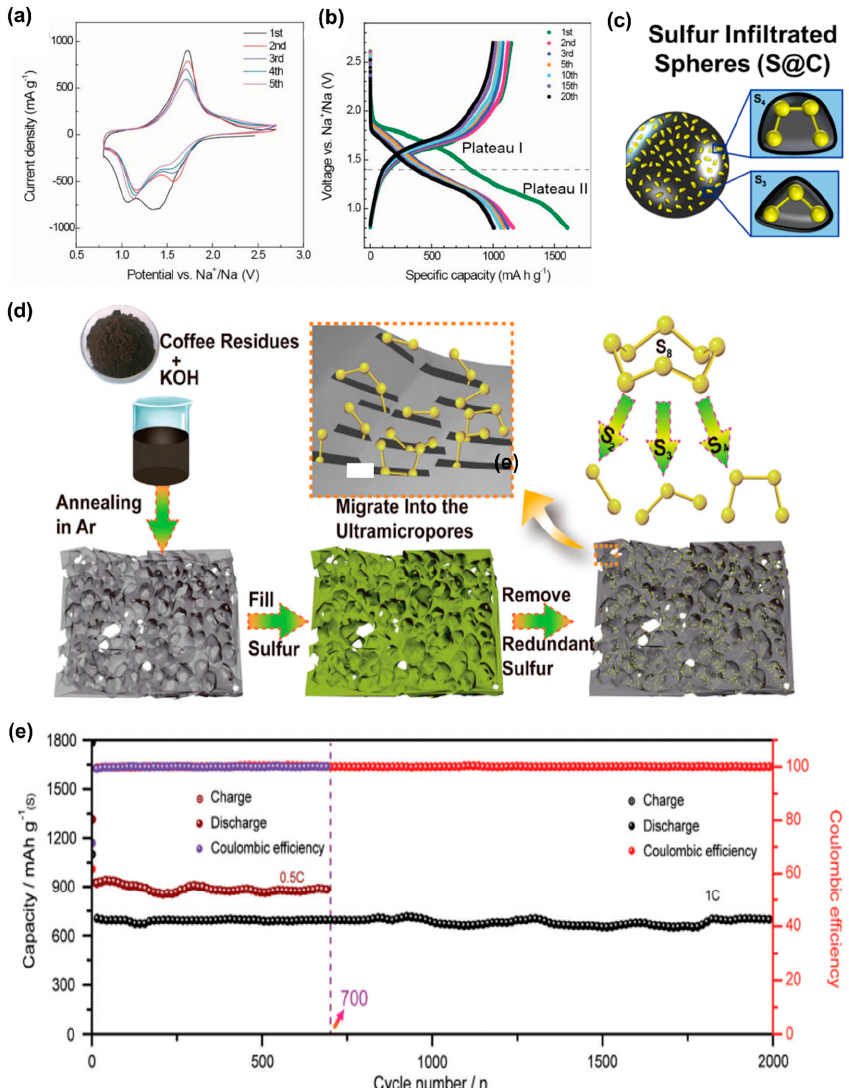
Figure 3. ( a ) CV and ( b ) voltage pro fi les of RT − NaSBswith sulfur encapsulated microporous carbon sheath electrode. Reproduced with permission [32]. Copyright 2014, Wiley. ( c ) Sucrose in fi